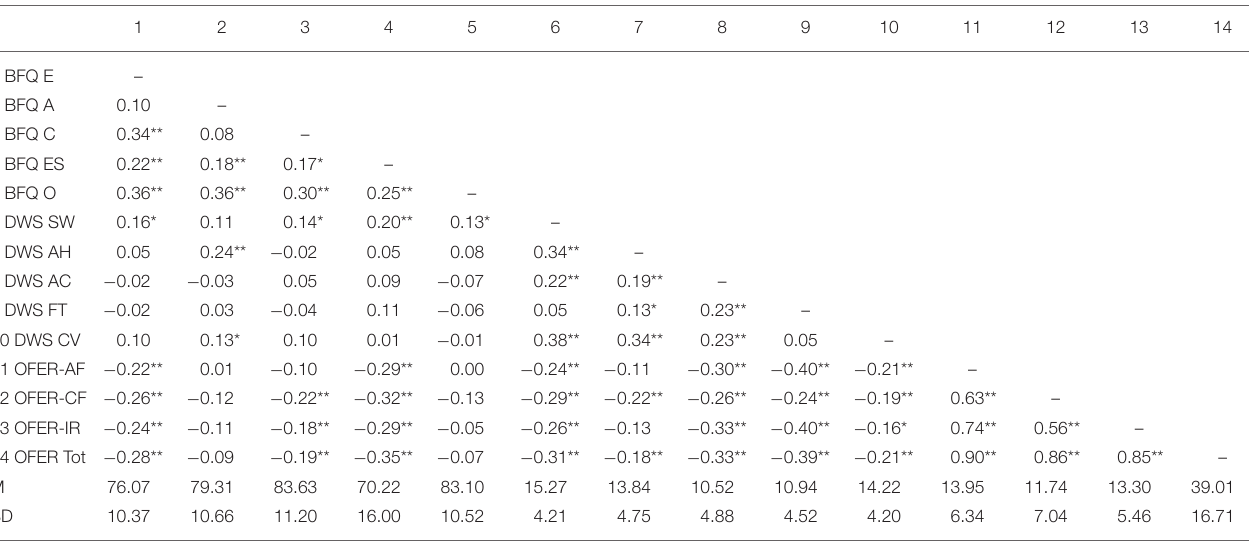
TABLE 1 | Zero order pearson